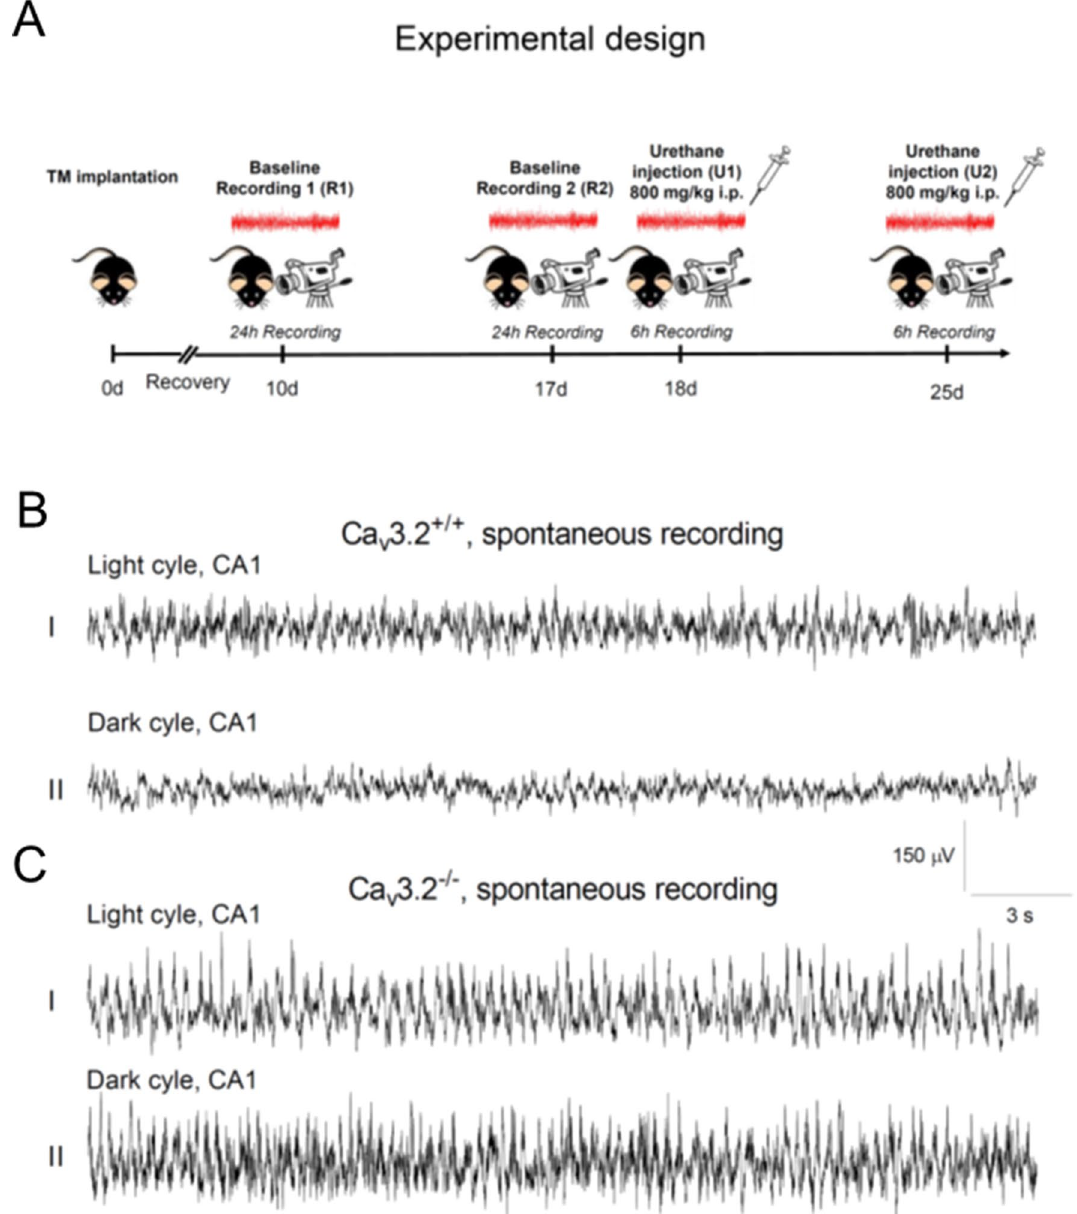
Figure 1. Experimental design and hippocampal EEG recordings from Ca v 3.2 +/+ and Ca v 3.2 −/− mice. ( A ) Experimental design including EEG radiofrequency transmitter (TM) implantation (day 0), a 10 days recovery period, two 24 h EEG long-term recordings (R1 at day 10, R2 at day 17) and two 6 h EEG recordings following urethane injection (800 mg/kg i.p., U1 at day 18, U2 at day 25). ( B , C ) Representative 30 s EEG traces from the CA1 region for the light ( B I , C I ) and dark cycle ( B II , C II ) R1 long-term recording from Ca v 3.2 +/+ ( B ) and Ca v 3.2 deficient mice ( C ). Note that Ca v 3.2 −/− mice display prominent theta/alpha activity compared to Ca v 3.2 +/+ animals, particularly during the inactive state (see “Results” section). Scale: y-axis, 150 μV; x-axis, 3